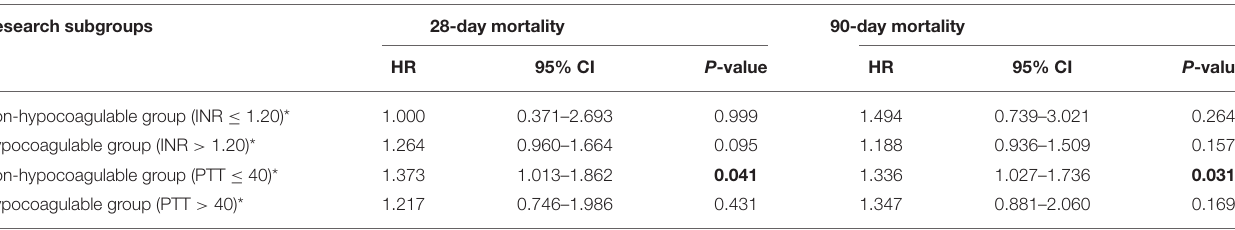
TABLE 4 | The sensitivity analysis with INR and PTT by the Cox regression models.